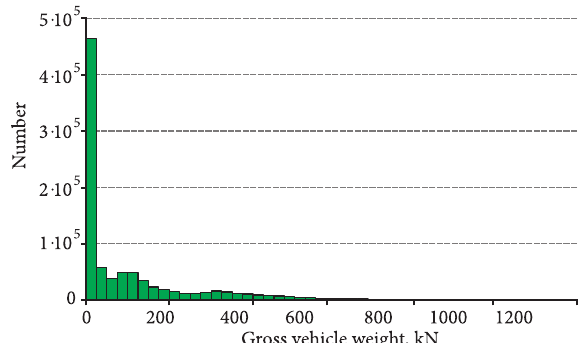
Fig. 7. Statistical histogram of gross vehicle weight